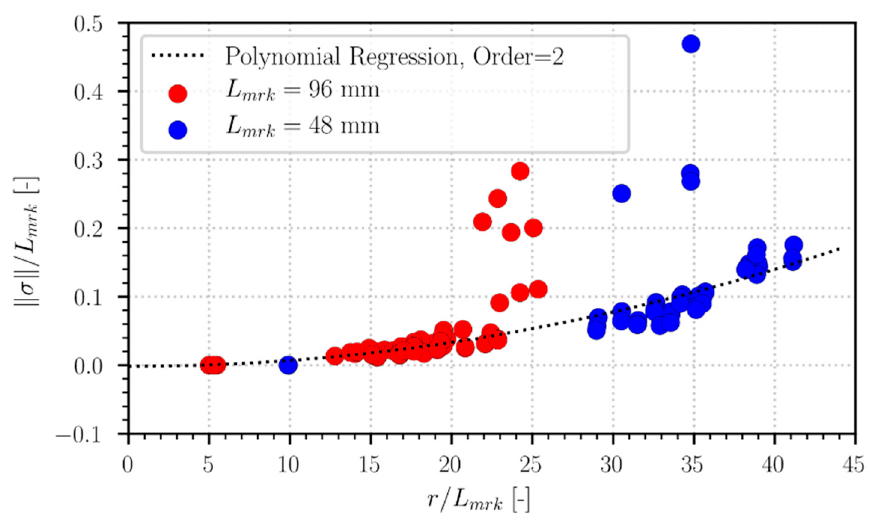
Figure 9. Localization accuracy as a function of distance from the camera. Values are normalized using the marker side length.